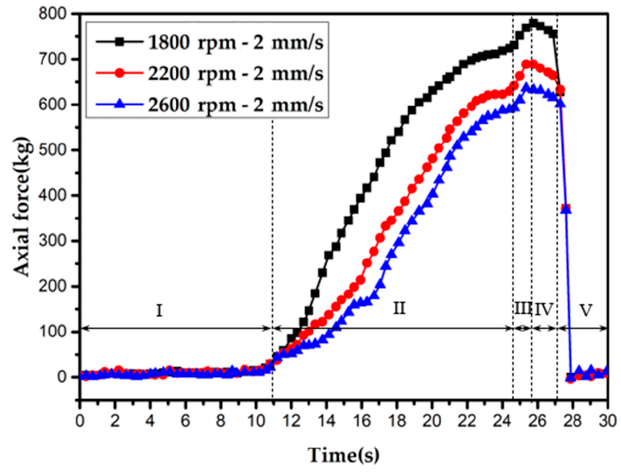
Figure 10. Axial force test result during FPW.